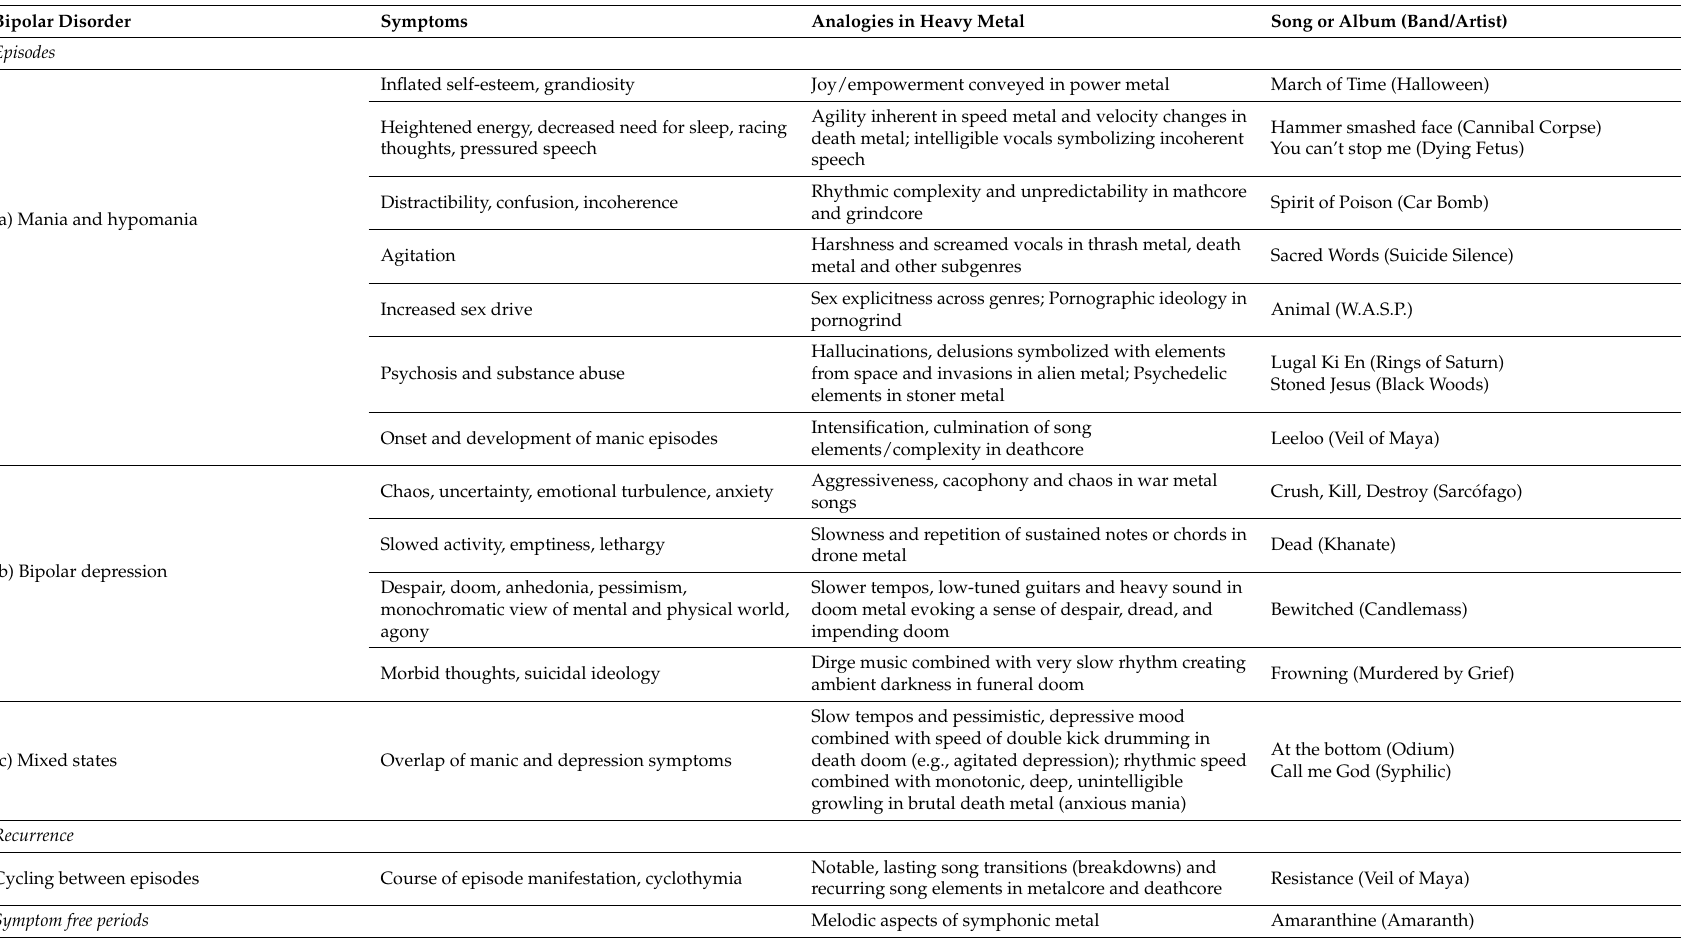
Table 1. Examples of metal songs and genres symbolizing selected aspects of bipolar disorder. Note that the examples are not exhaustive and meant for demonstration only. Note also that several metal analogies apply to different aspects of bipolar disorder highlighting their wider application for expressing the